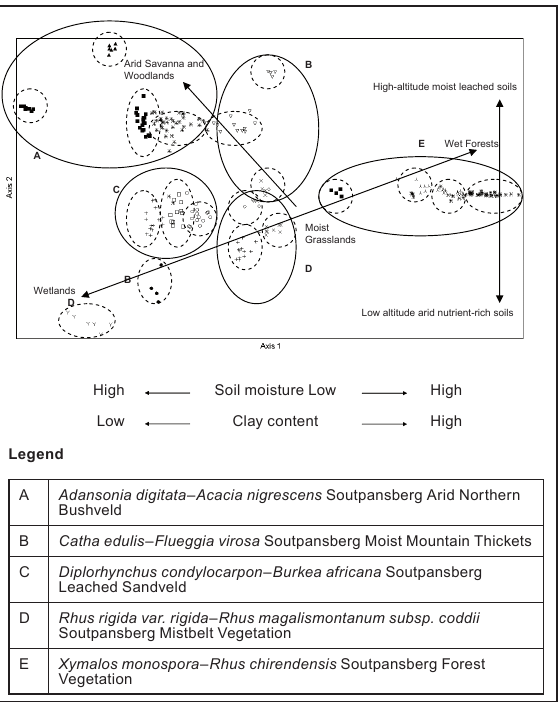
Figure 5 Relative positions of relevés along the first and second axis of the DECORANA ordination (Hill 1979b) of the vegetation data from the Soutpansberg